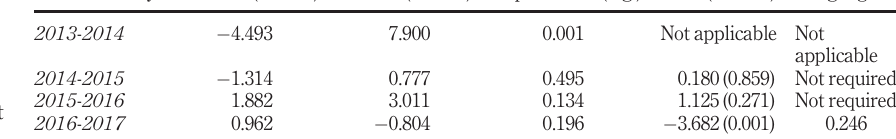
Table 10. Result of dependent samples t -test (comparison over